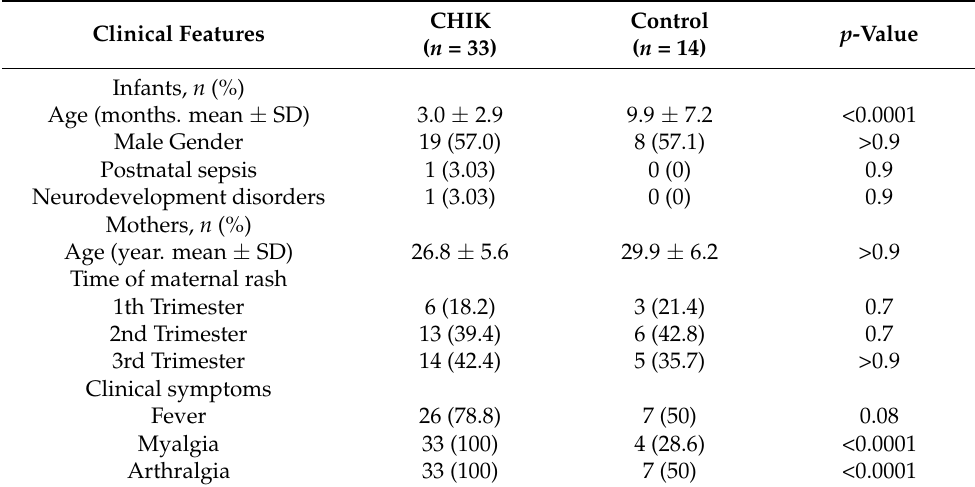
Table 1. Demographic and clinical data of mothers infected with CHIKV during pregnancy and their intrauterine exposed infants recruited from 2017 to